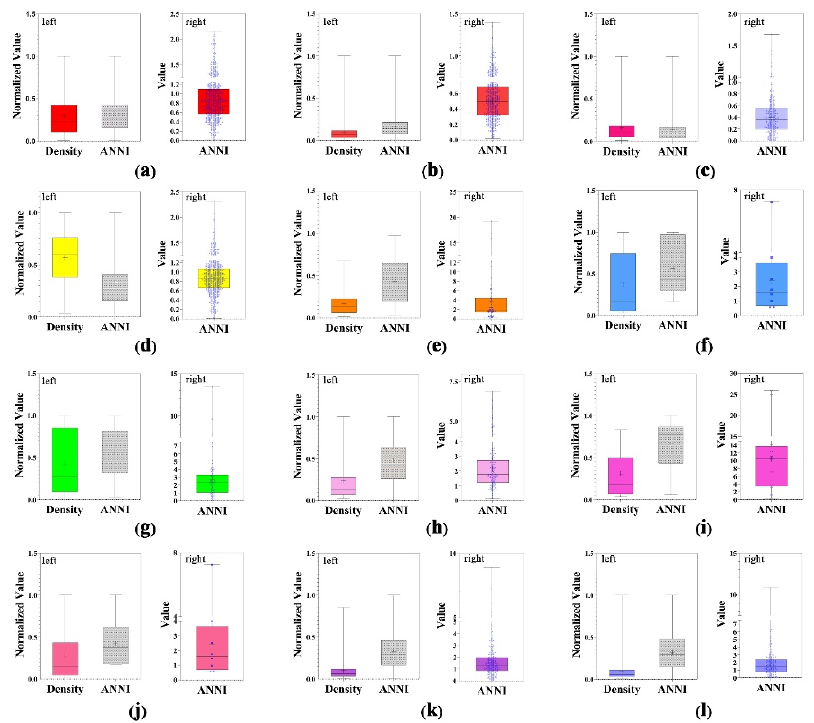
Figure 6. Spatial statistics on average-nearest-neighbor indexes and densities of different types of POIs: ( a ) Business; ( b ) Commercial; ( c ) Administrative Office; ( d ) Residential; ( e ) Industrial; ( f ) Street and Transportation; ( g ) Green Spaces; ( h ) Education; ( i ) Medical Health; ( j ) Sport Facilities; ( k ) Cul- tural Media; ( l ) Research. Left: the normalized density and normalized average-nearest-neighbor indexes; Right: the average-nearest-neighbor index value.